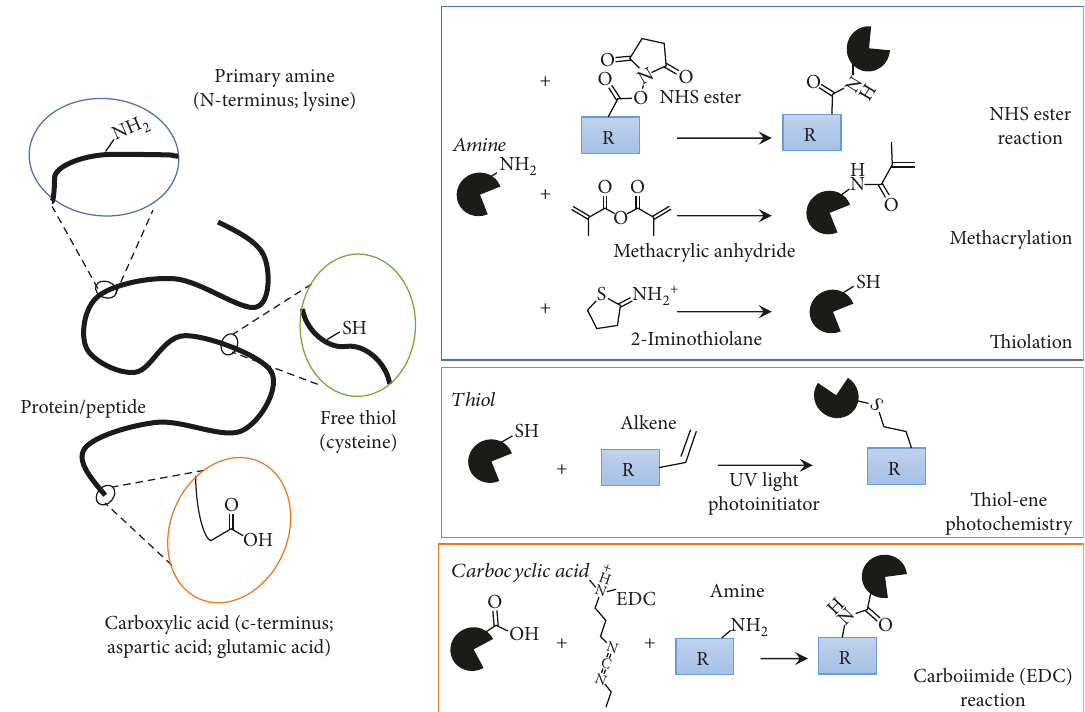
Figure 4: Commonly targeted modi fi cation sites on proteins/peptides and their respective covalent bioconjugation